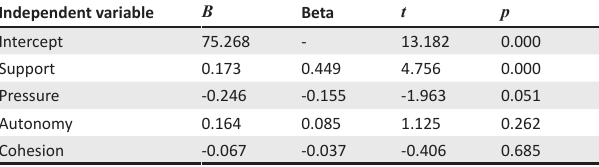
TABLE 7: Results of multiple regression of psychological climate subscales on psychological